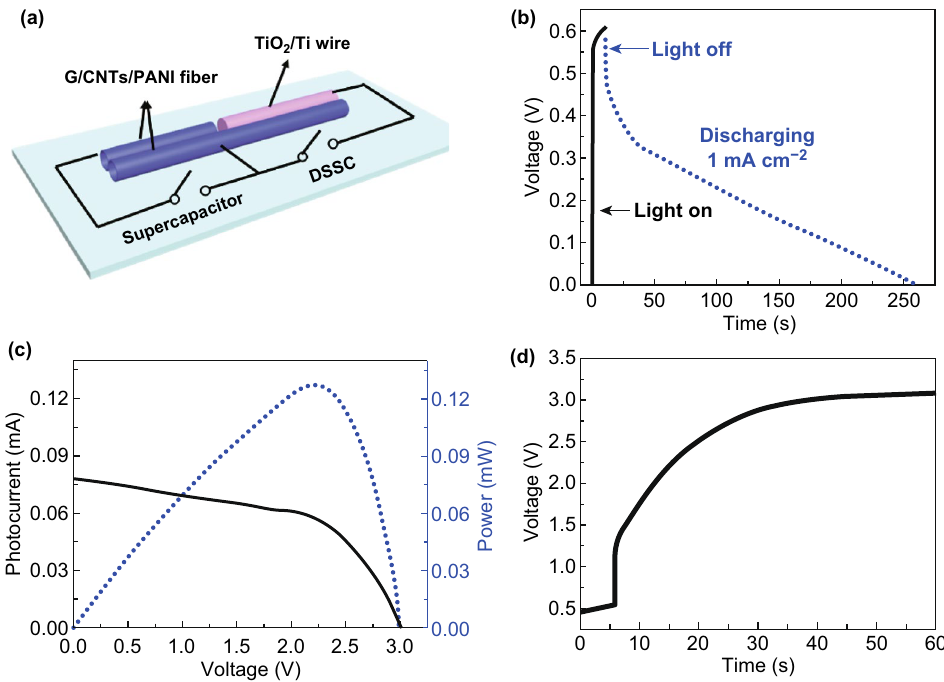
Fig. 5 a Schematic illustration of integrated energy conversion and storage device with G/CNTs/PANI hollow fiber as the common electrode. b Dynamic voltage curves of photocharging and galvanostatic discharging processes of the integrated device. c Typical J – V curve (black curve) and voltage–power curve (blue curve) of five fiber-shaped DSSCs connected in series. d Solar-charging curve of five integrated devices con- nected in